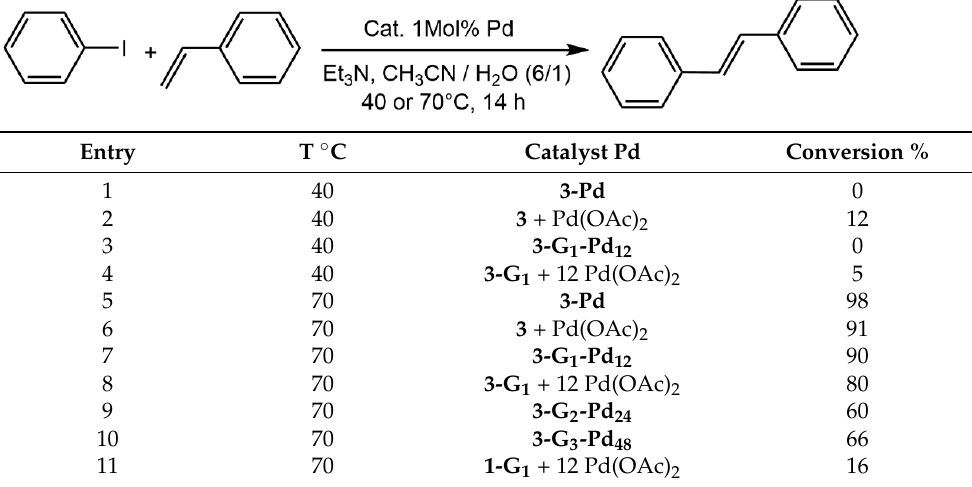
Table 2. Catalysis of Heck couplings between iodobenzene and butyl